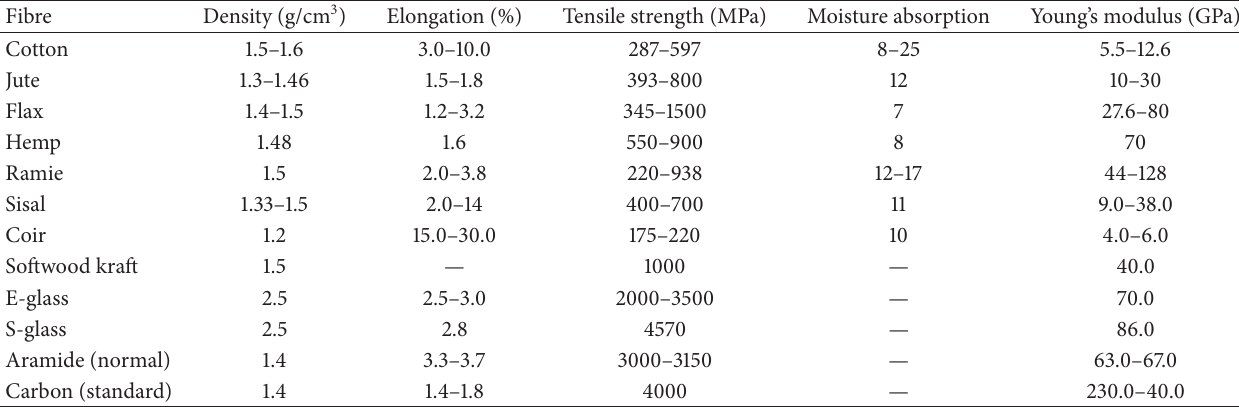
Table 3: Mechanical properties of natural fibre [44, 45].